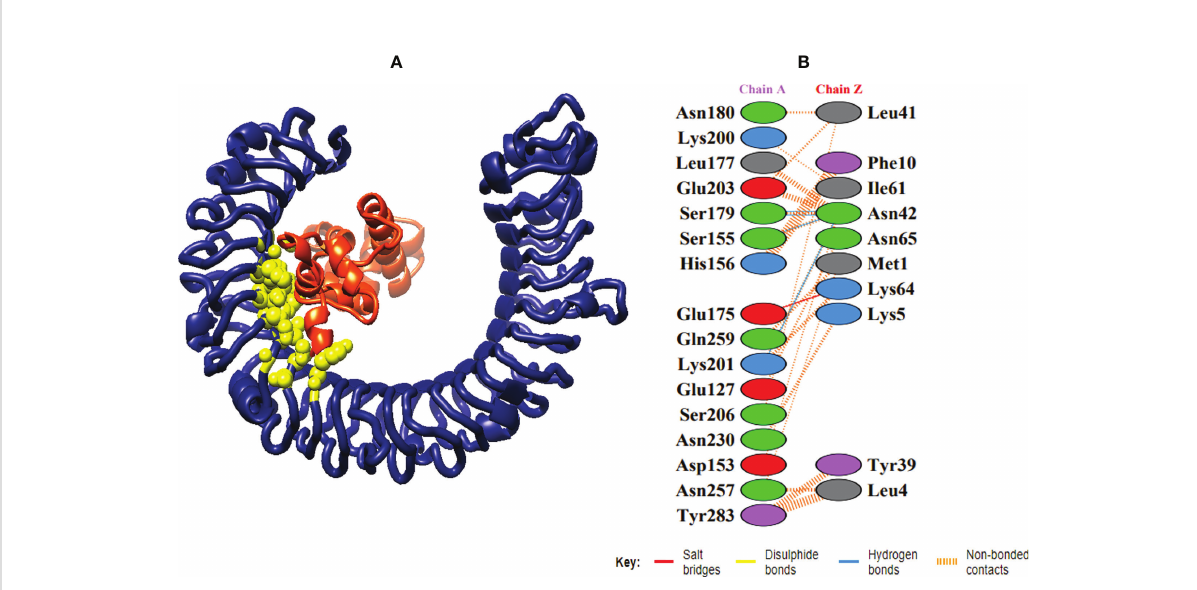
FIGURE 7 Schematic illustration of MEMPV-TLR3 docked cluster. (A) Docked pose of MEMPV-TLR3 docked cluster. Construct in orange-red, TLR3 receptor in navy blue and interacting residues between immune receptor and vaccine are shown in yellow color. (B) Dimplot of vaccine construct-TLR3 docked